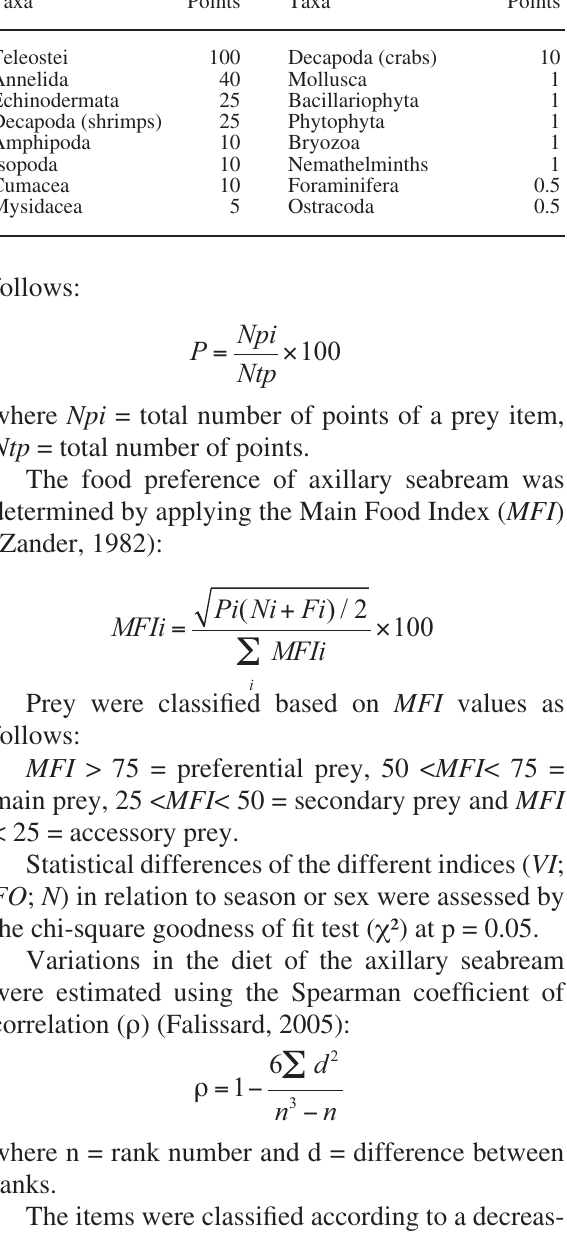
Table 4. – seasonal variations of the vacuity index ( VI, % ) of P. acarne in juveniles and